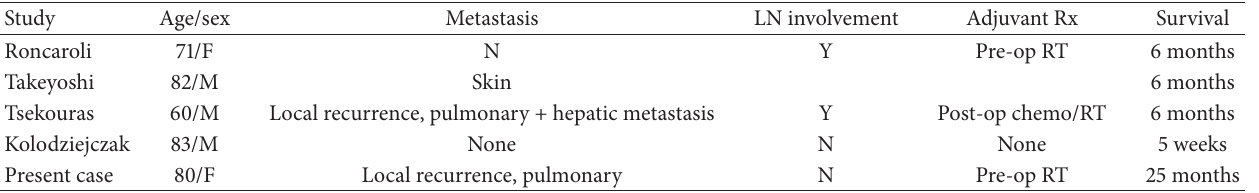
Table 1: Patient characteristics of previous case reports of rectal carcinosarcoma.